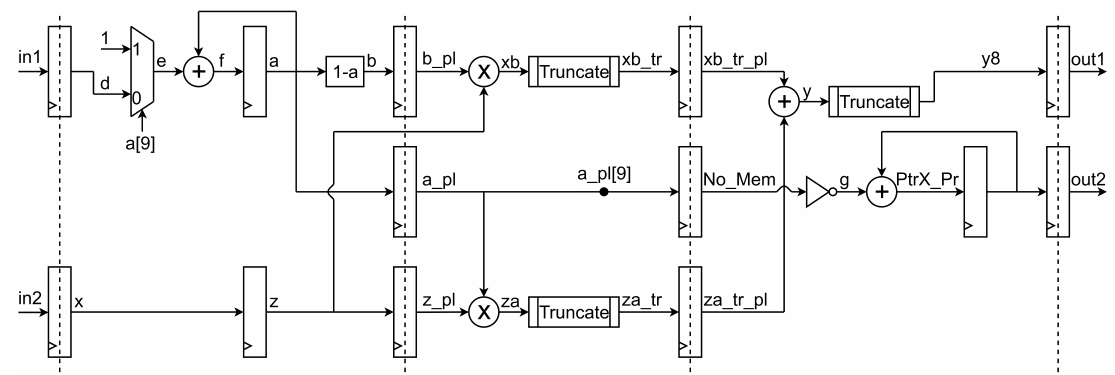
Figure 8. Circuital implementation of the proposed algorithm with pipeline registers (pipeline levels are highlighted with dashed lines).